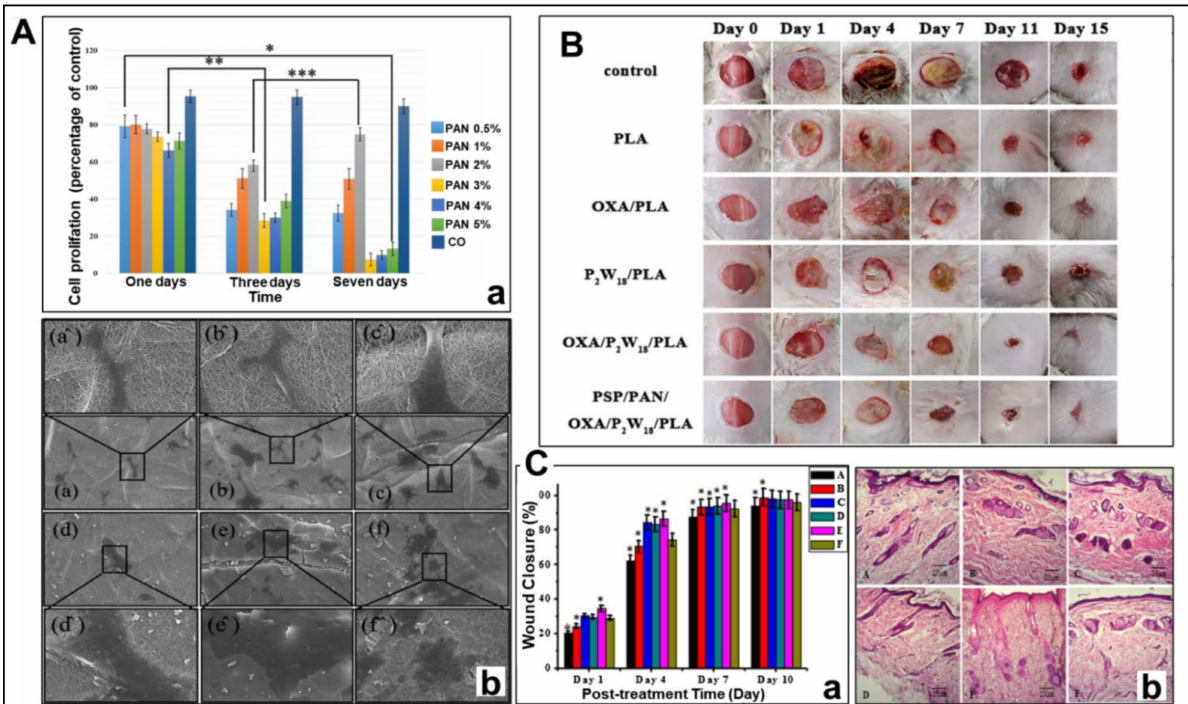
Figure 13. Effect chart of different wound dressings. ( A ) In vitro cell proliferation and cell ad- hesion experiments of PVA-DSs/PAN-GENs core-shell nanofibers [195]. ( a ) Cell proliferation of different samples on days 1, 3, and 7; ( b ) Cell adhesion and cell migration of different samples ( a – f , PVA-DSs/PAN-GENs core-shell nanofibers with 0.5, 1, 2, 3, 4, and 5% w/w PAN/GENs solutions, respectively); ( B ) Wound healing using PSP/PAN/OXA/P 2 W 18 /PLA nanofiber dressing, Reprinted with permission from [231], copyright 2022, American Chemical Society. ( C ) Wound healing study using PAN-moringa extract nanofiber dressing, Reprinted with permission from [196], copyright 2018, American Chemical Society. ( a ) The wound closure rate of PAN-moringa extract nanofiber dressings with different concentrations of Moringa oleifera on the wound for 1, 4, 7, and 10 days; ( b ) Skin tissue images of PAN-moringa extract nanofiber dressings with different concentrations of Moringa oleifera on the 11th day of wound use (Samples A – F in this study, where A is only pure PAN nanofibers, the content of Moringa oleifera extract in B – E is 0.1, 0.15, 0.2, and 0.5 g, respectively, and F is a positive